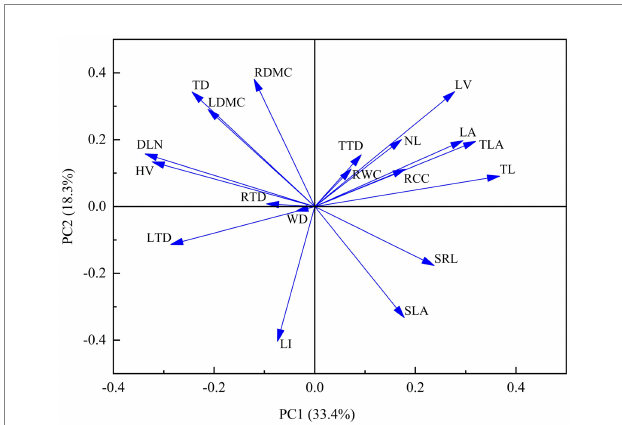
FIGURE 6 PCA analysis of functional traits of different organs of Abies georgei var. smithii. in southeast Tibet.